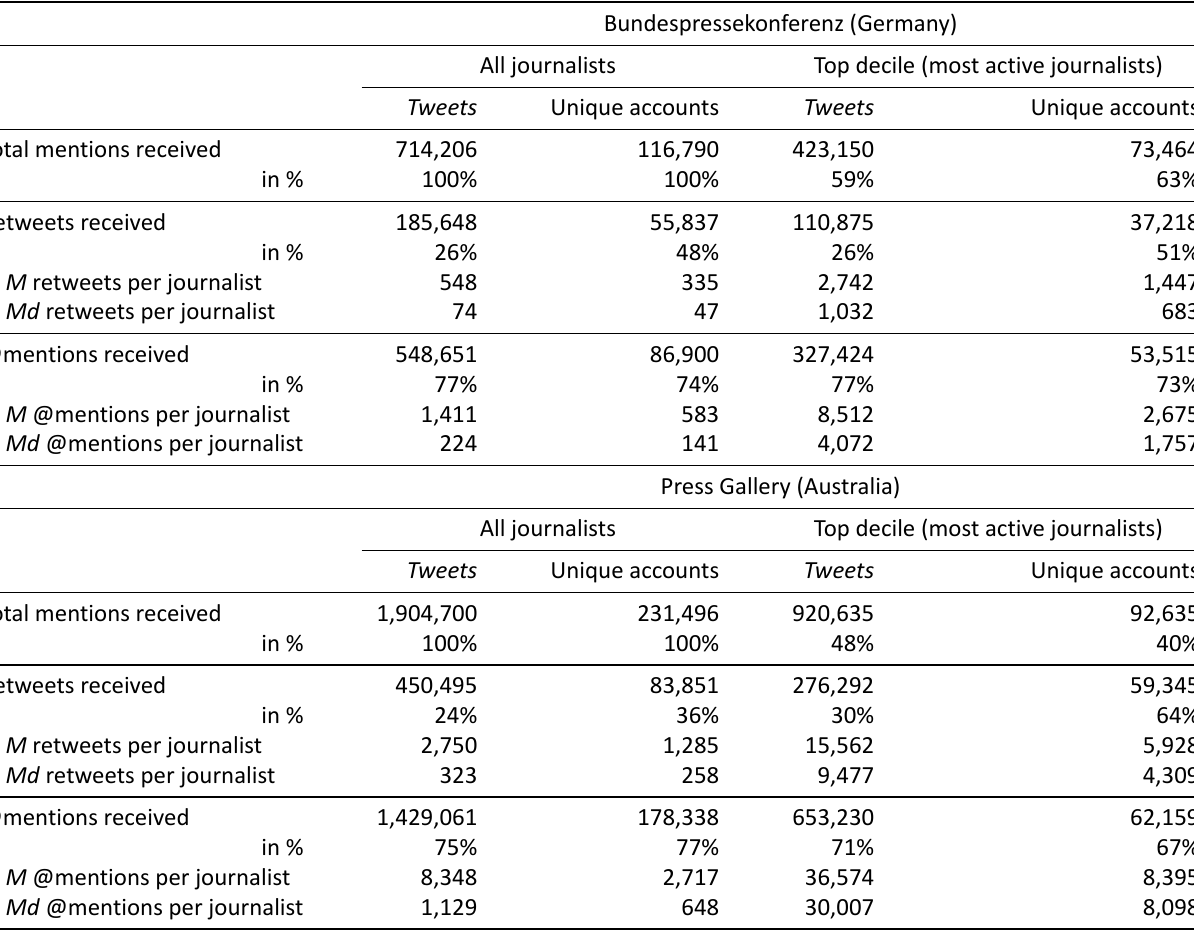
Table 3. Engagement metrics for press corps journalists